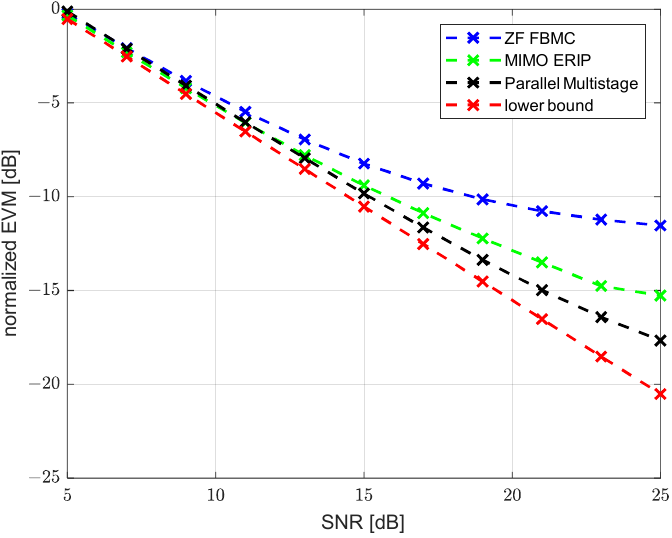
Figure 10. EVM performance versus SNR for HFLQ channel model.